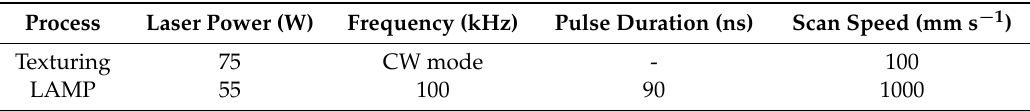
Table 1. Laser parameters used in microstructure fabrication and laser joining